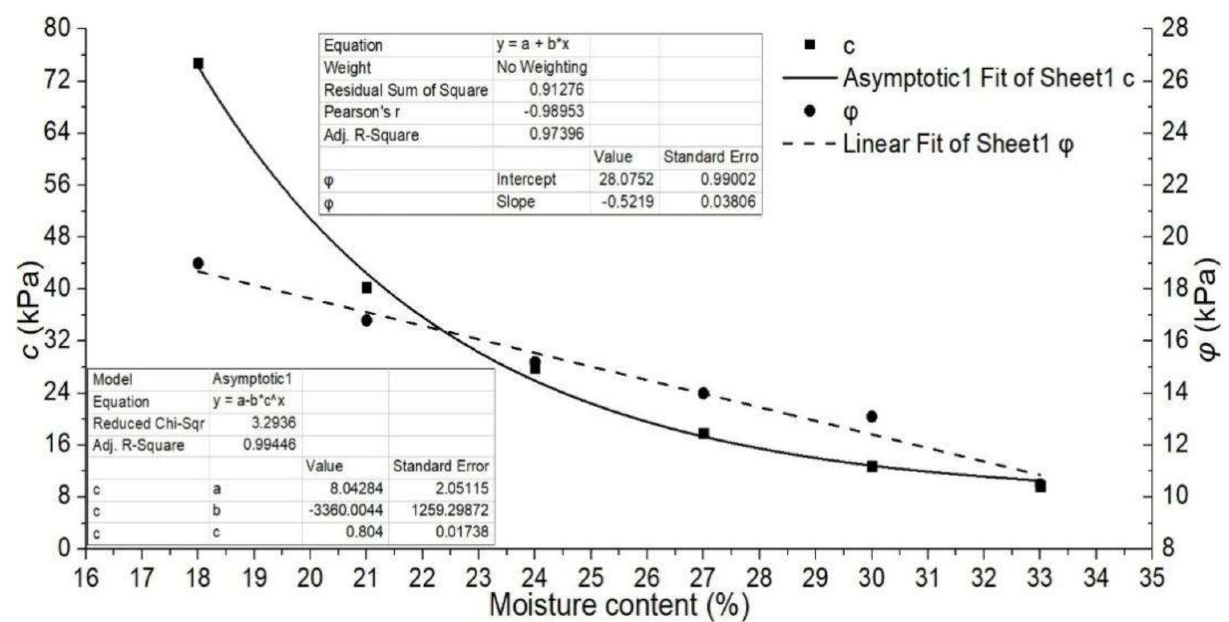
Figure 16. Relationship between soil moisture content of the slope and shear